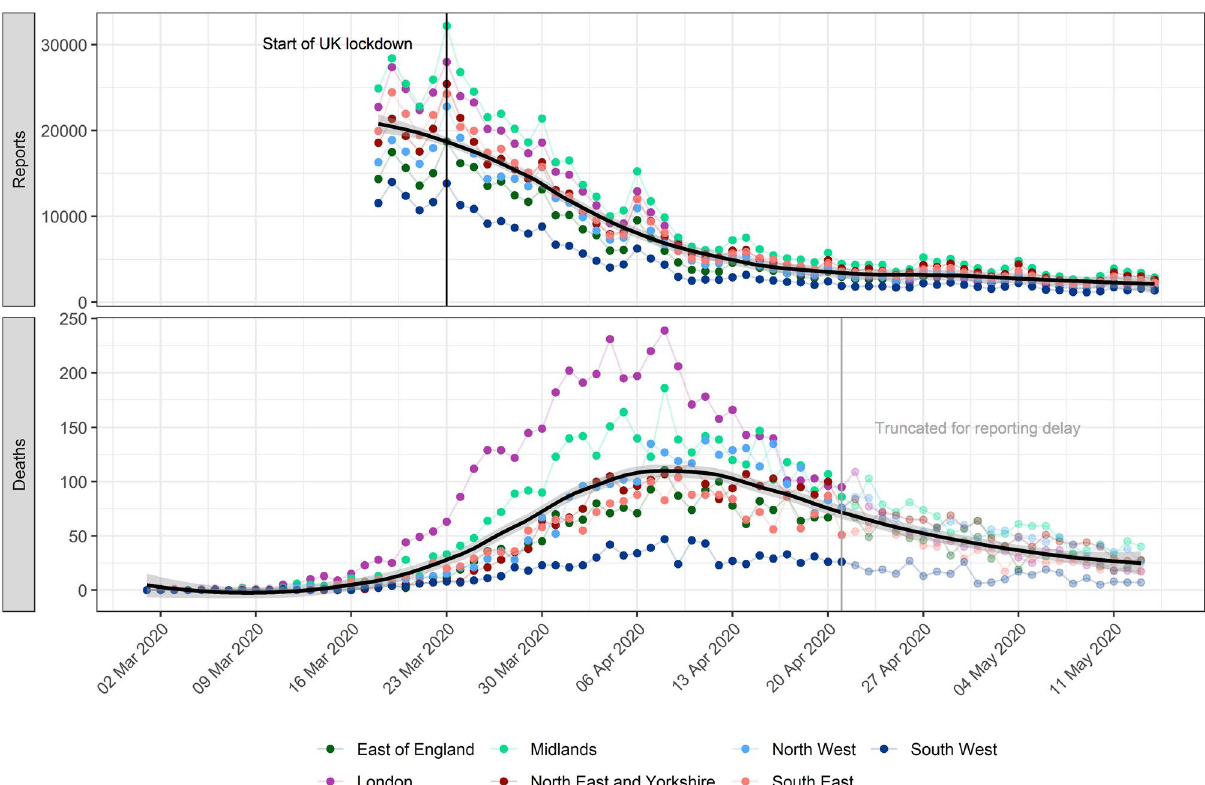
Figure 1. Daily potential COVID-19 cases reported through NHS Pathways and reported COVID-19- related deaths, by NHS region. Pathways data include calls to 111 and 999, as well as 111-online reports. Dates correspond to the date of case report and death report, respectively, with x-axis labels corresponding to Mondays. The solid black line and grey ribbon correspond to a lowess smoother and its 95% confidence interval, calculated across all data points and NHS regions. The start of the lockdown in England (23rd March 2020) and date at which death data were truncated to avoid bias from reporting delay (21st April 2020) are highlighted by vertical